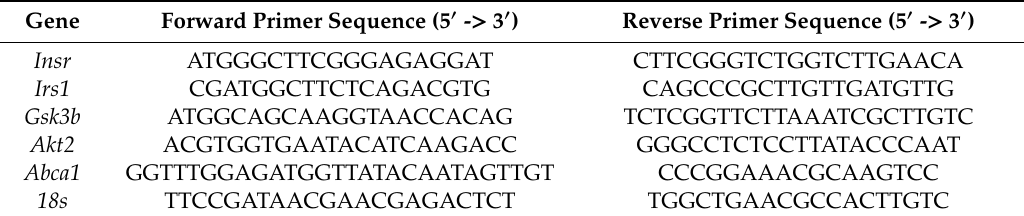
Table A3. List of primers used for QRT-PCT analysis in mice tissue. Gene